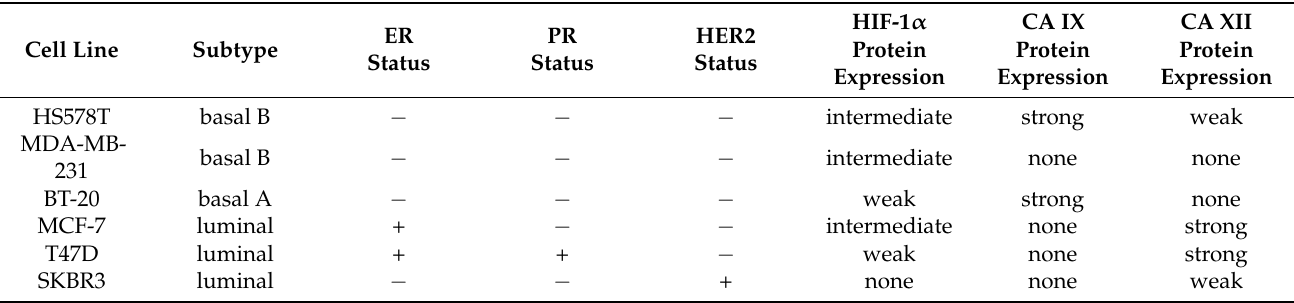
Table 1. Characterization of breast cancer cell